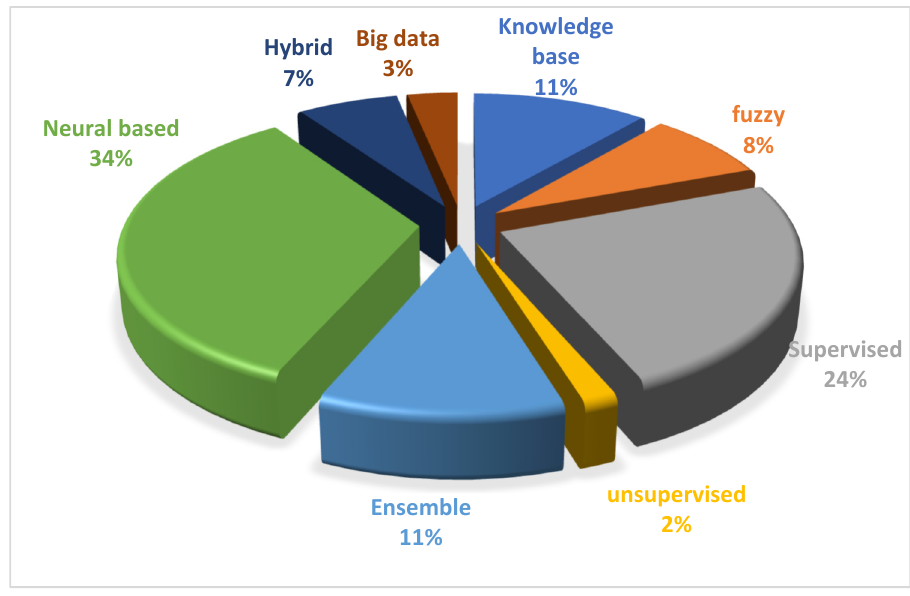
Figure 11. Percentage distribution of the methods for ES/DSS development for ECG interpretation .